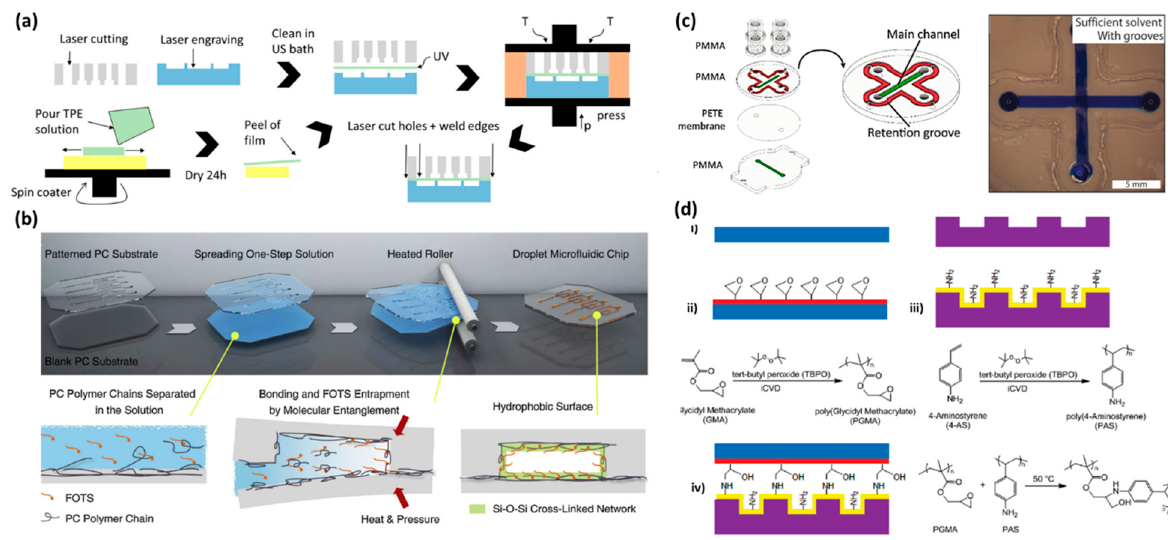
Figure 3. ( a ) Fabrication process of laser cut PMMA microchannels (pneumatic channels in gray and a fluidic channel in blue) sandwiching a TPE film. The device was bonded via UV assisted thermal fusion bonding. Reproduced with permission [30] 2022, MDPI. ( b ) Solvent bonding of PC microfluidic channels. FOTS molecules are entangled with the polymer chains and hydrolysed. Reproduced with permission [25] 2022, Elsevier. ( c ) Retention grooves embedded in microfluidic design to promote the solving bonding process in a PMMA ‐ based microfluidic device. Reproduced with permission [66] 2022, Elsevier. ( d ) Chemical bonding of thermoplastic layers via iCVD polymerization of poly(glycidyl methacrylate) (PGMA) and poly(4 ‐ aminostyrene) (PAS). ( i – iv ) The induced chemical groups on the surface at each step. Reproduced with permission [115] 2022, ACS publications.